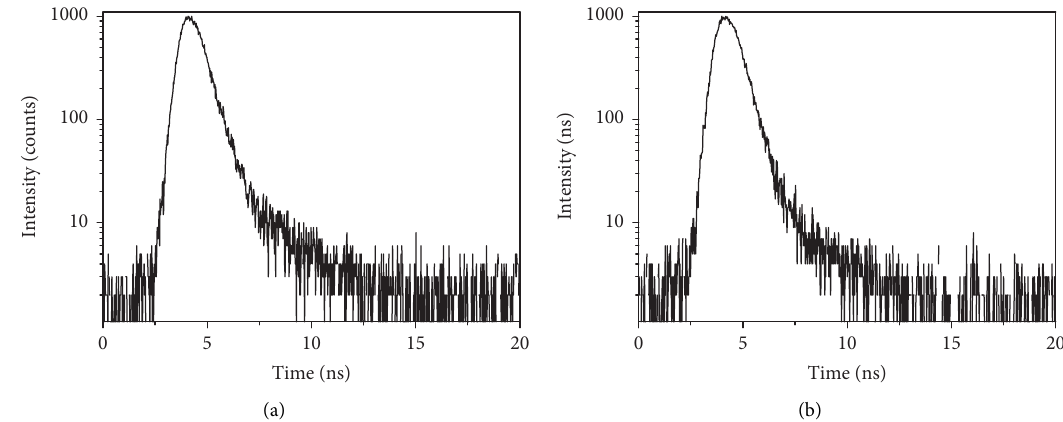
Figure 6: Fluorescence decay curves of P4 (a) and P4 ′ (b) in dilute